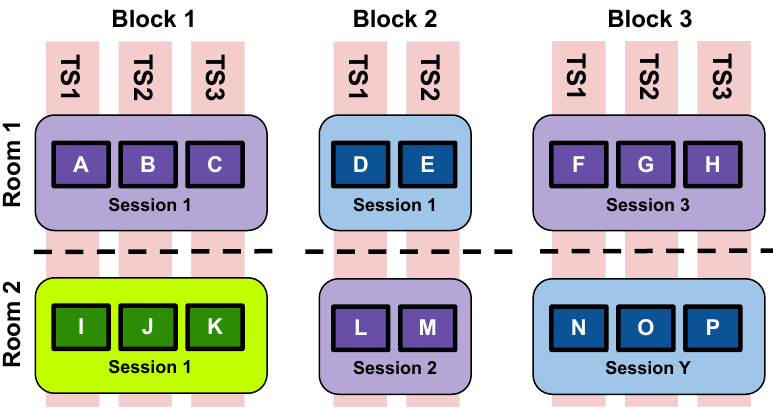
Figure 4. Example of a conference with 16 talks, three tracks, three blocks and two